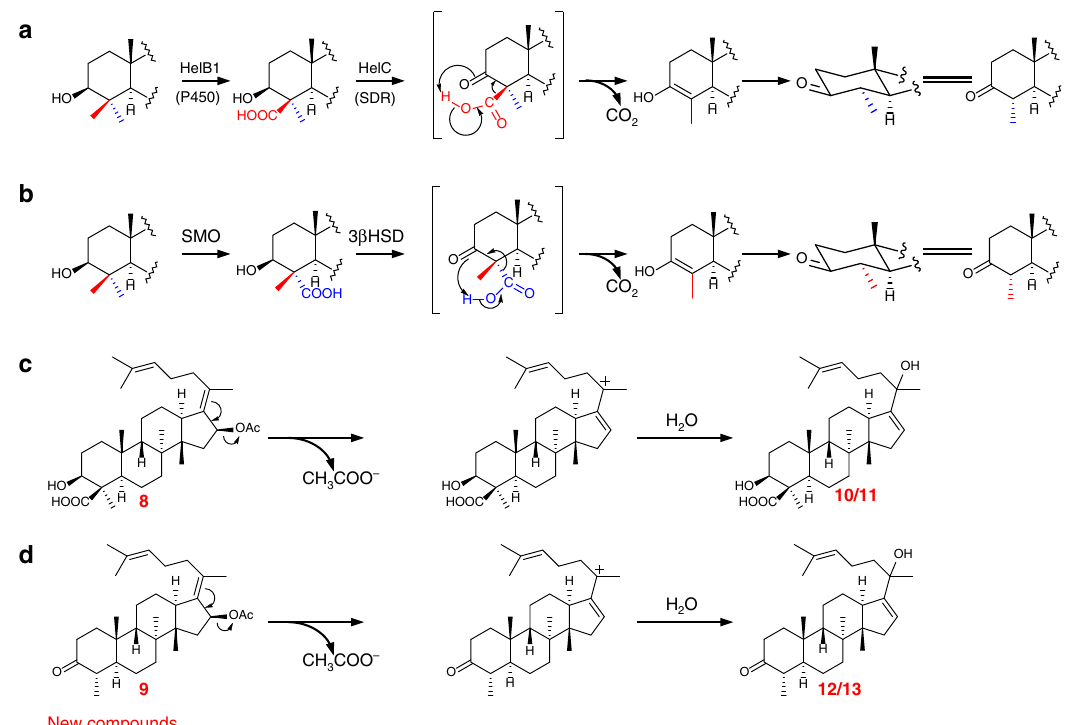
Fig. 5 Proposed reaction mechanisms. a C-4 demethylation process in helvolic acid biosynthesis; b C-4 demethylation process in sterol biosynthesis; c Proposed mechanism for transformation of 8 to 10 / 11 ; d Proposed mechanism for transformation of 9 to 12 / 13 − 1 (~20 mg L ) (Fig. 2h and Supplementary Fig. 9). Taken together,